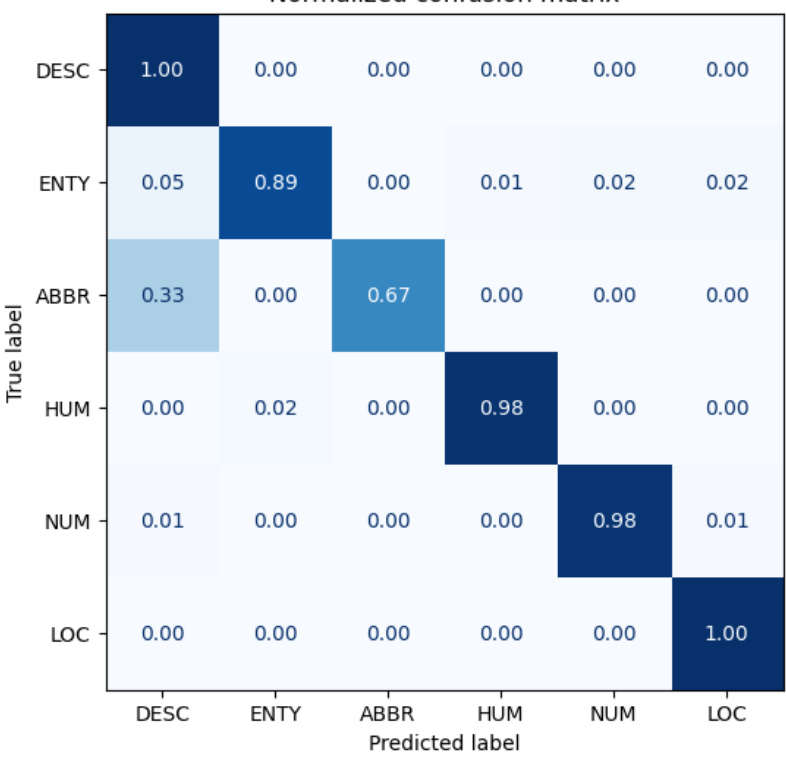
Figure A3. Antonym2 Run2 Confusion Matrix on TREC.